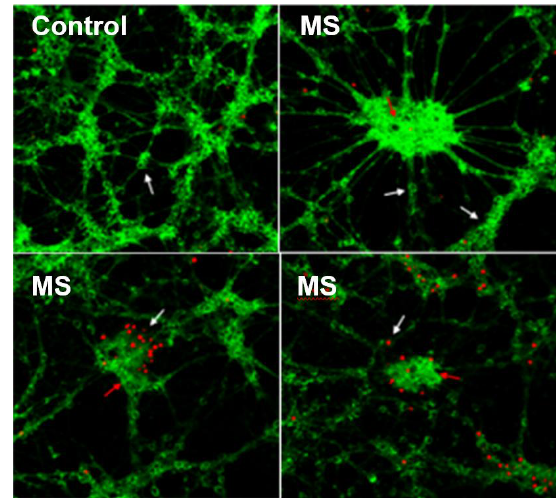
(red arrow). Fourteen-days culture of CGNs were treated with cerebrospinal fluid (CSF) of Multiple Sclerosis (MS) patients and stained with propidium iodide (red fluorescence) and rhodamine-123 (green fluorescence). The images correspond with three independent